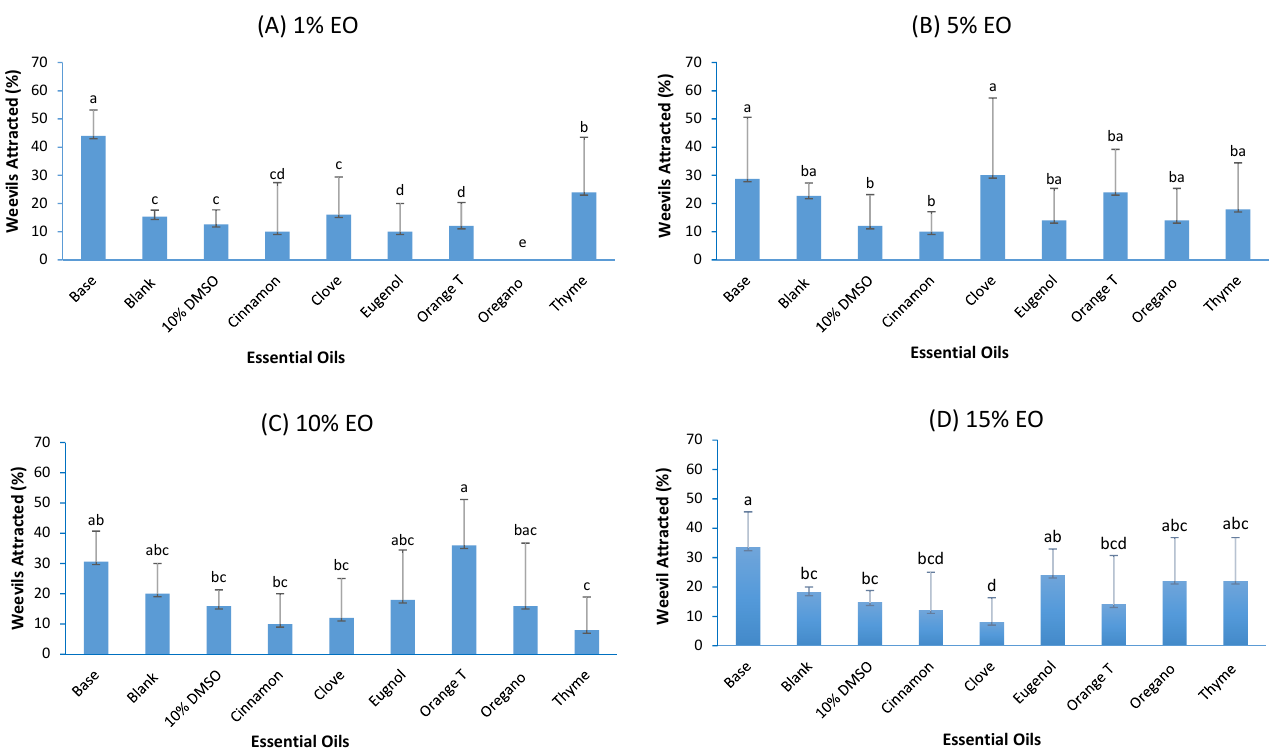
Figure 1. Percentages of maize weevils attracted to different essential oils at their different concentrations (Base—the bottom of the central chamber of olfactometer where the weevils were added. Blank is the negative control that did not have any EO or 10% DMSO on the cotton ball). Data bars with different labels are significantly different at 5% significance level.